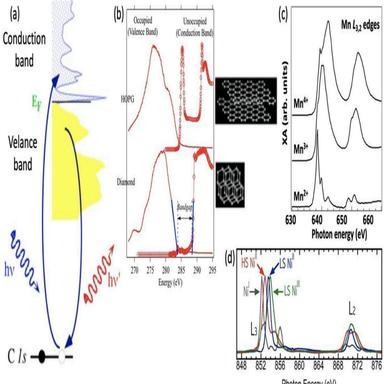
(a) A diagram of the carbon 1s electron is excited to empty 2p electronic states after adsorbing an x-ray photon and valence electron fill up the core hole and emit an x-ray photon, (b) C K-edge XAS and XES spectra of HOPG and diamond with both π and σ bonds in HOPG and only σ bond in diamond, (c) Mn L-edge XAS of different Mn oxidation states, (d) Ni L-edge XAS of different Ni oxidation states and also comparison of high-spin and low-spin states.